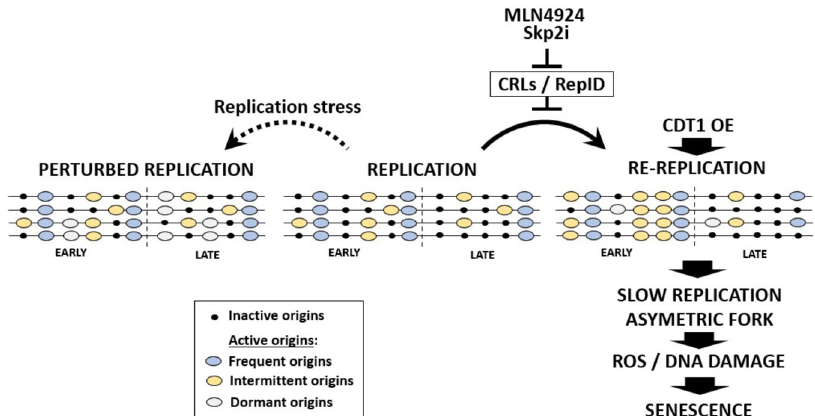
Fig. 6 A model of replication origin usage during re-replication. Re-replication can be induced by pharmacological inhibition of the CRL ubiquitin ligases complexes (MLN4924, Skp2 inhibitor) or by depletion of cellular components recruiting CRLs to chromatin (e.g., RepID). Both strategies lead to CDT1 stabilization and abnormal high cellular levels of CDT1. Re-replication can also be induced by CDT1 overexpression. Re-replicating origins are markedly enriched for sequences that are normally replicated during the early stages of genome duplication, and replication initiation is repressed in late- replicating regions. Intermittent origins, de fi ned as origins that are activated intermittently during normal genome duplication, initiate replication at a higher frequency during re-replication. Activation of intermittent origins results in shorter inter-origin distances and slower replication fork progression than during normal mitotic growth, re fl ecting frequent replication fork stalling. In cells undergoing replication stress, excess initiation triggers activation of dormant origins, which do not initiate replication during normal growth. Re-replication may activate some dormant origins, but at a notably lower frequency compared to dormant origins induced by aphidicolin and SIRT1 depletion. Over-activation of origins and frequent stalling can lead to DNA damage, ROS production and eventually trigger